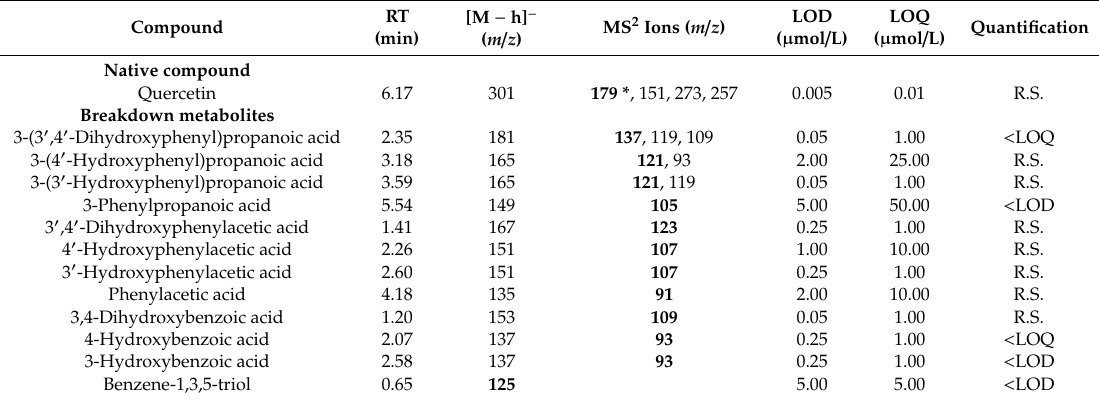
Table 2. UHPLC-MS n identification of native quercetin and its phenolic metabolites monitored in fermented samples.